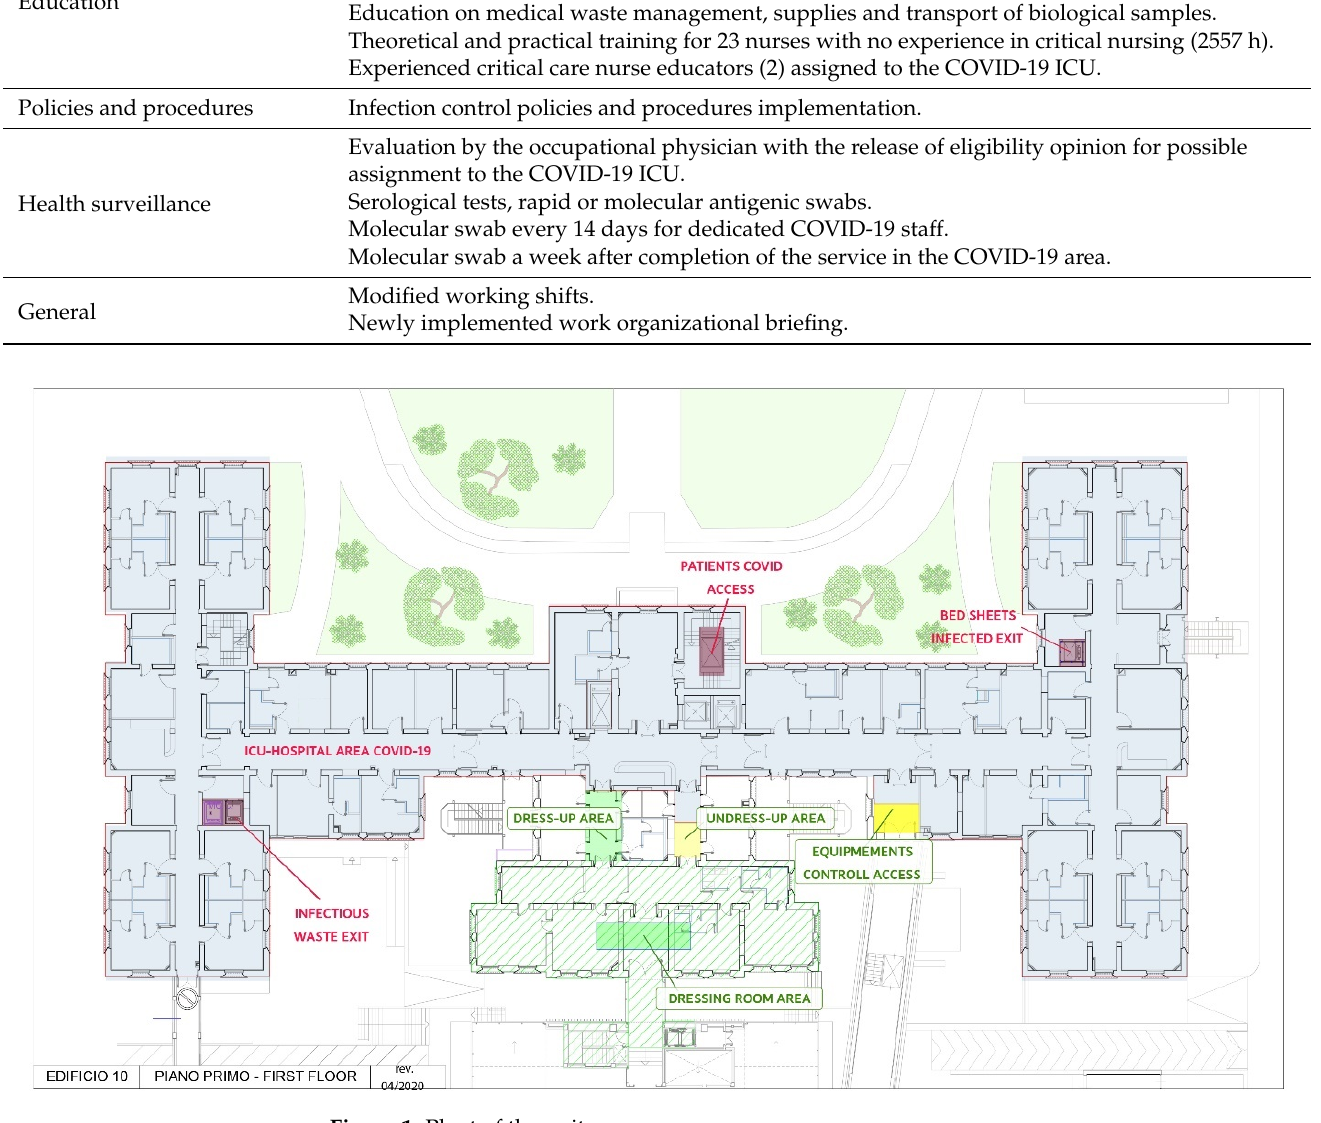
Figure 1. Plant of the unit.